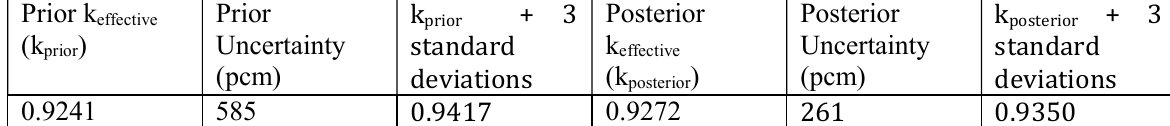
Table I.: Prior and Posterior Statistics using 175 Experimental Configurations